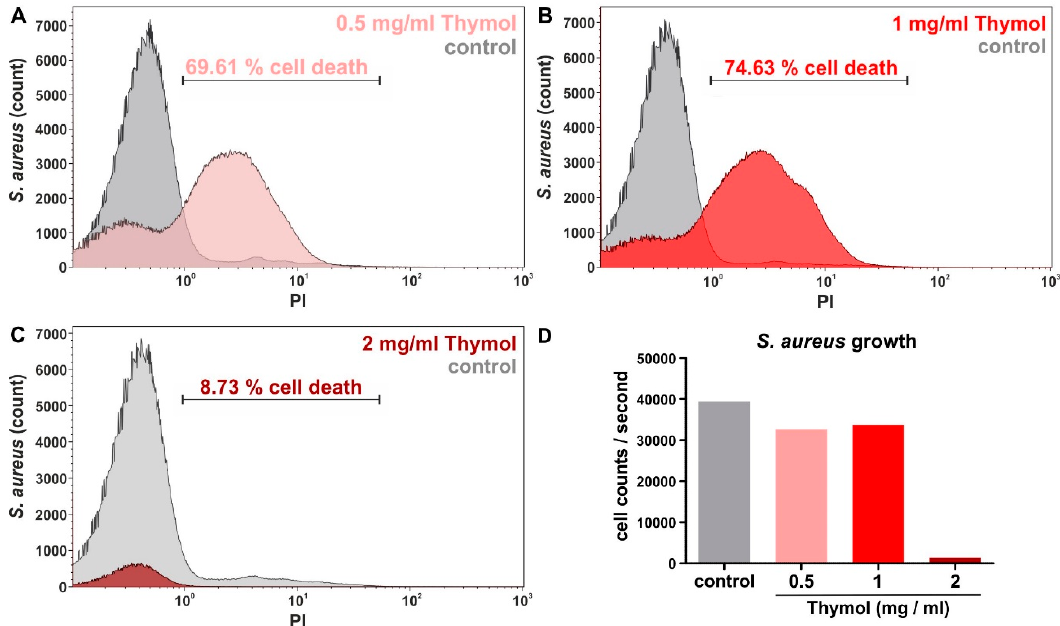
Figure 8. Flow cytometric analysis of cell death validate invasomes encapsulating thymol to be strongly bactericidal against Gram-positive bacteria like S. aureus . ( A , B ) Compared to untreated negative control, 0.5 mg/mL or 1 mg/mL thymol packaged in invasomes resulted in a profound cell death depicted by PI-staining. ( C ) 2 mg/mL thymol packaged in invasomes resulted in only 9% PI-stained S. aureus. ( D ) Assessment of cell flow revealed only around 1000 cells/second in the S. aureus population treated with 2 mg/mL thymol-comprising invasomes, suggesting a nearly complete cell death prior to following flow cytometric analysis. PI: Propidium iodide.